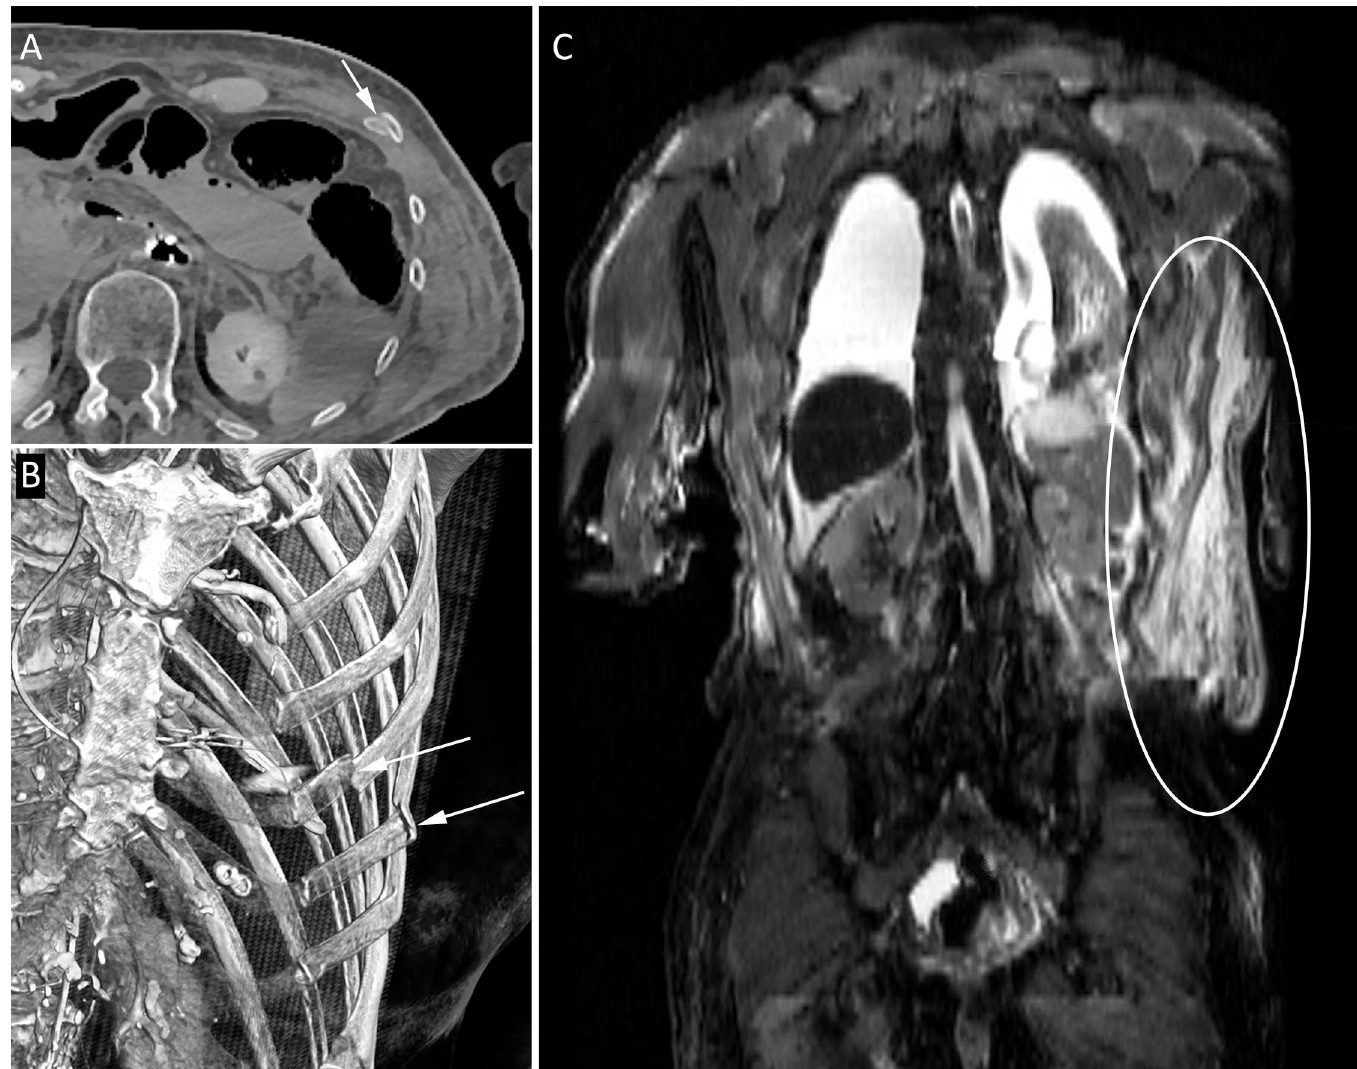
Fig 6. Rib fractures with soft-tissue hematoma. 89-year-old woman who underwent an elective coronary angiography for mitral valve insufficiency and complaints of angina. During the procedure she developed cardiac arrest and required cardiopulmonary resuscitation. She was transported to the intensive care, where she showed symptoms of hypovolemic shock and she died shortly afterwards. Postmortem CT showed multiple rib fractures (A and B: arrows) and on postmortem MRI a large soft- tissue hematoma was seen in the left flank (C: ellipse).